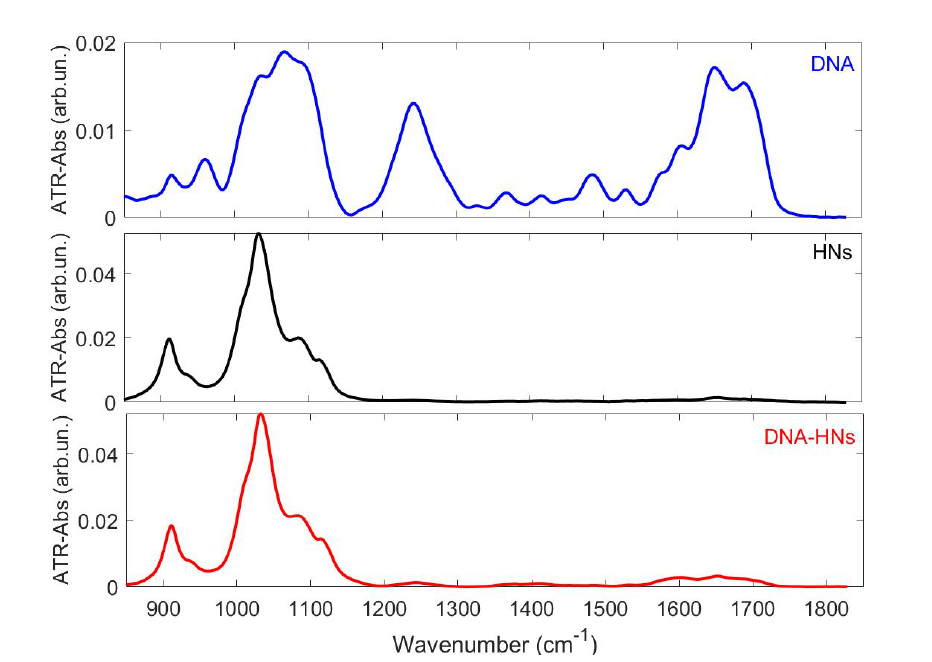
Figure 2. ATR-FTIR spectra of HNs (black), DNA–HNs (red) and DNA (blue) in the region between 850 and 1850 cm − 1 . For the assignment of vibrational bands, see Table 1. Table 1. Infrared peak positions and chemical group assignment for DNA, HNs and DNA–HNs obtained from the second derivative of ATR-FTIR spectra reported in Figure 2 and of DNA–HNs (nano DNA–HNs) obtained from nano-FTIR spectra reported in Figure 3